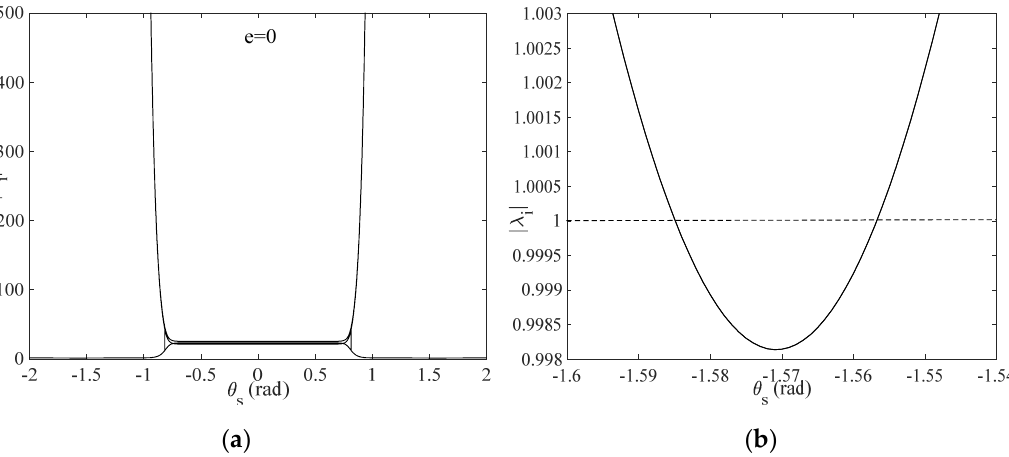
( b ) θ , 0 e = ; ( b ) local enlargement of Floquet multipliers